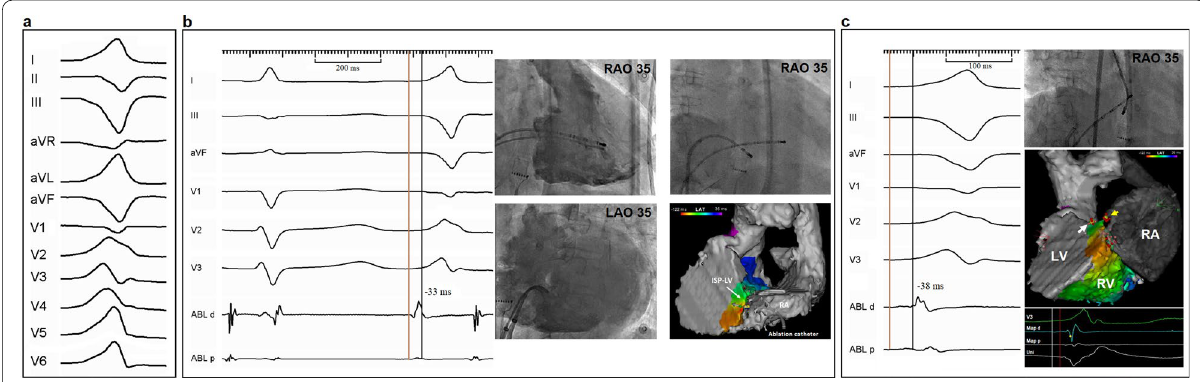
Fig. 3 a A 12‑lead ECG of the clinical PVC. b Left panel : intracardiac EGM at the ablation site of the inferior septal process via an RA approach showed V and A signals. Middle panel : right ventriculography. Right panel : fluoroscopic view and electro‑anatomical mapping with ablation catheter positioning via the RA infero‑medial aspect, which is adjacent to inferior septal process. c Left panel: intracardiac EGM at the successful ablation site showed the earliest ventricular activity of 38 ms preQRS. Right panel : the application of RF energies at the inferior septal process via a retrograde trans‑aortic approach. Note the far‑field signal of PVC at the distal ablation might indicate intra‑mural origin. Yellow arrow showed the ablation site via RA approach, and white arrow indicates the successful ablation site from retrograde approach. Note that, the sandwich lesion sets